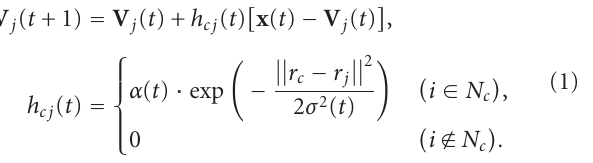
were mapped onto the map array. After the self-organizing learning, five Japanese vowels vocalized by six di ff erent peo- ple were mapped onto the feature map. Same vowel